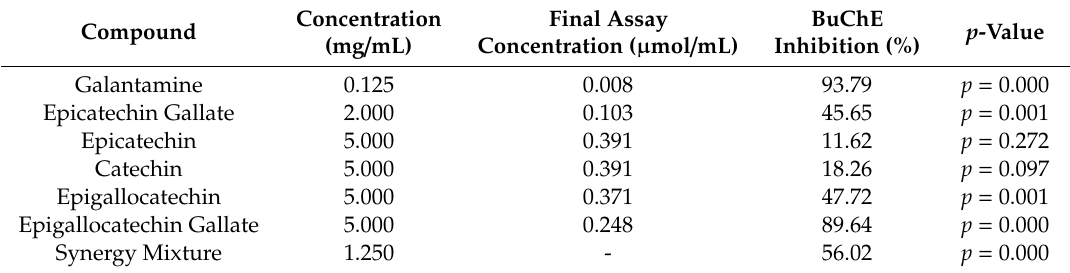
Table 8. BuChE inhibition: initial tests for BuChE inhibition at the highest concentrations available for each compound. Only compounds showing statistically significant levels of inhibition (p < 0.01) were tested